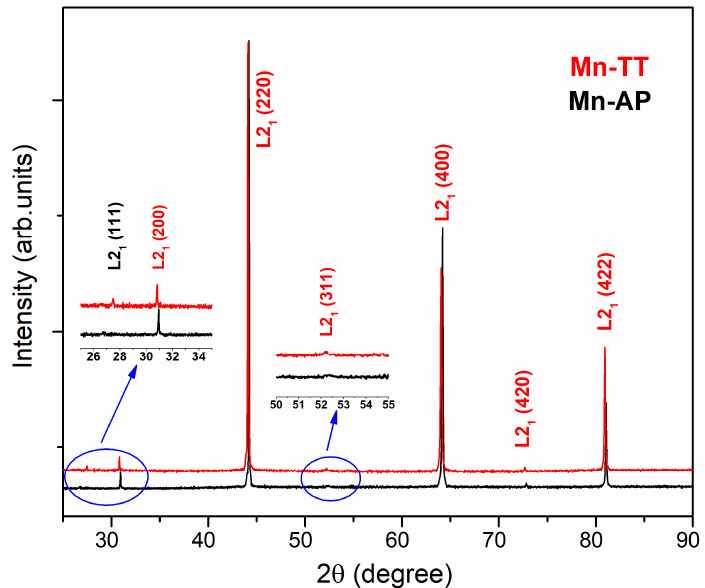
Figure 1. X-ray diffraction patterns recorded on the CS for the as-prepared (Mn-AP) and thermally treated (Mn-TT) ribbons at room temperature.